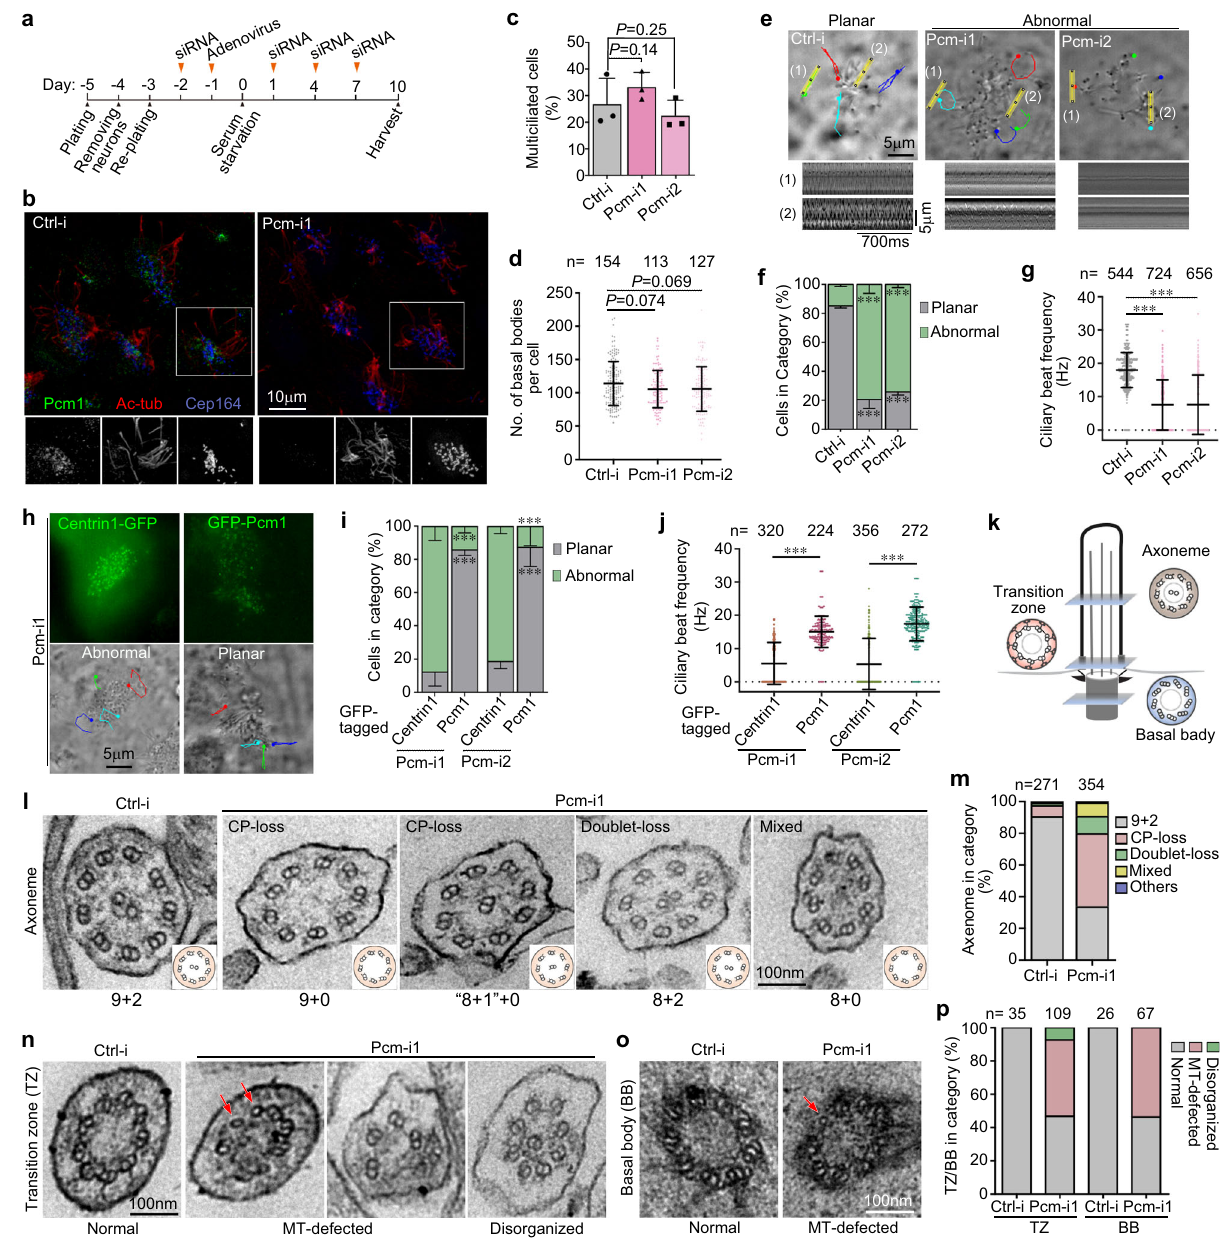
FGMs enrich multiple centriole-related proteins . As Pcm1 itself does not localize in the deuterosome, basal body,